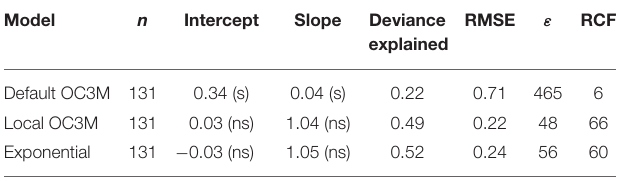
TABLE 3 | Comparison of accuracy of the default (global Case 1) and local model predictions using the TASCAM monitoring buoy test dataset; n = sample size and significance test results are shown in brackets.